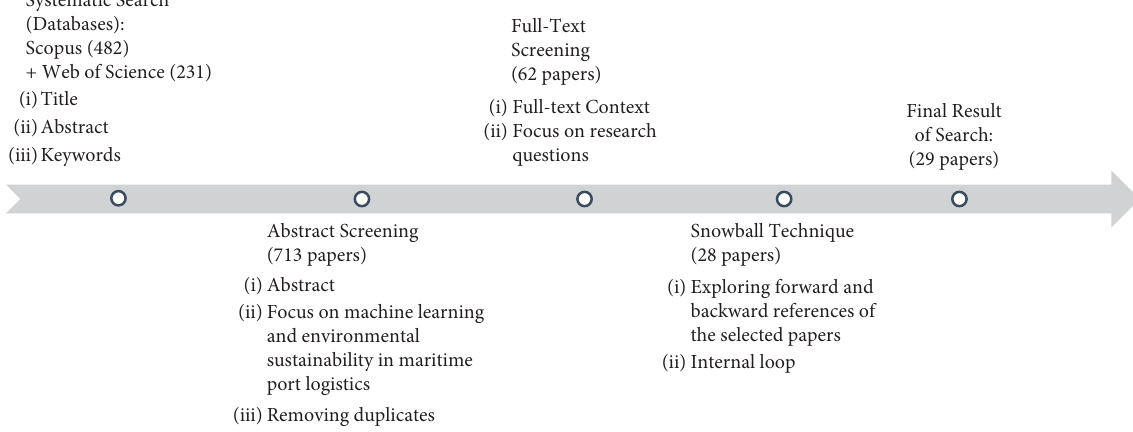
Figure 1: Te overall procedure for selecting and fltering the articles